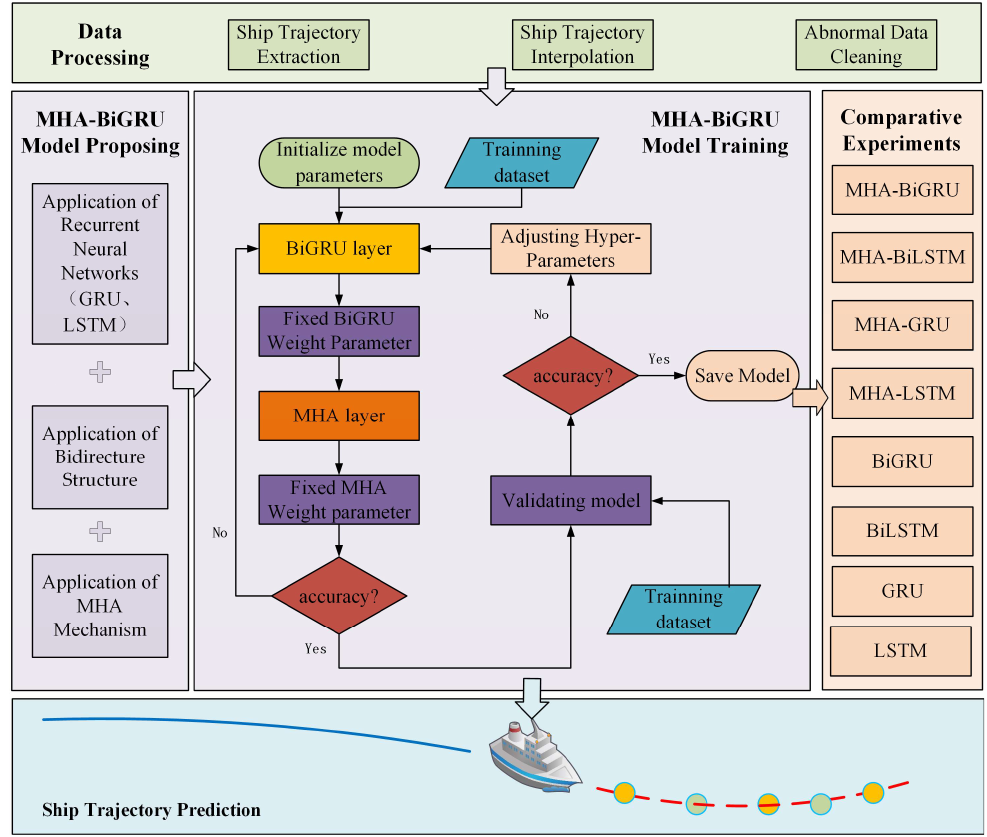
Figure 1. Flowchart of the ship trajectory prediction method.